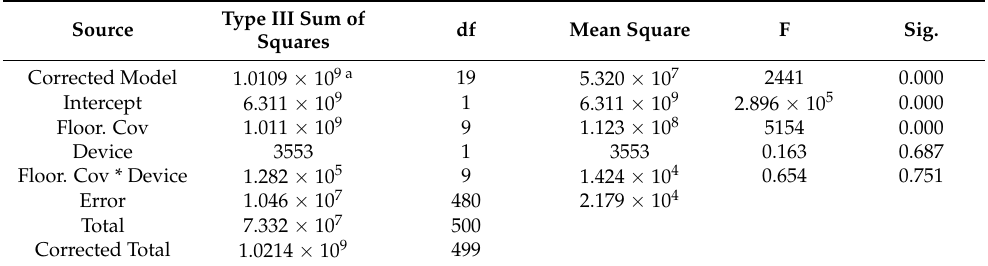
Table 3. Univariate analysis results for highest valleys, dependent variable: highest valleys